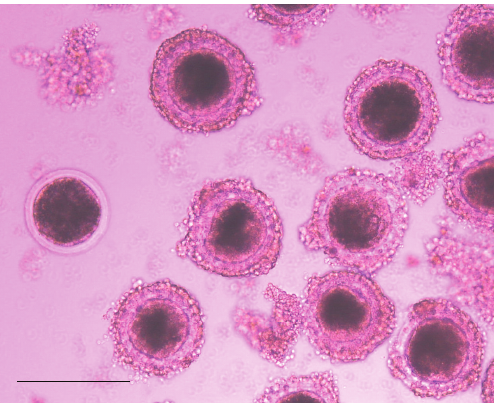
Figure 1: Morphological appearance of immature pig